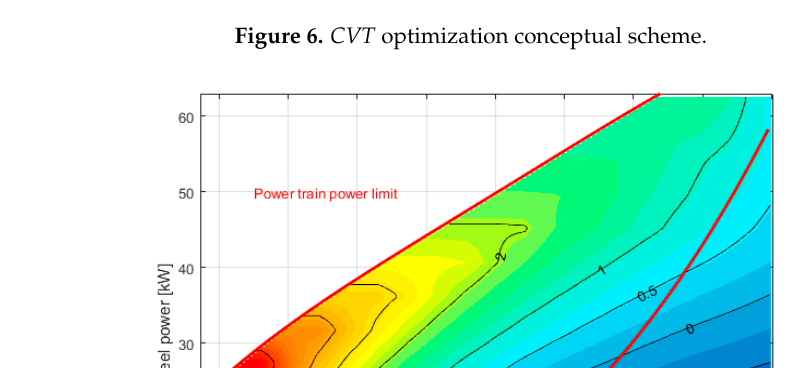
Figure 6. CVT optimization conceptual scheme.